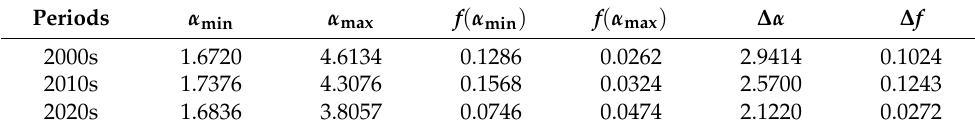
Figure 8. The multifractal spectrum of the Yellow River Basin in the ( a ) 2000s, ( b ) 2010s, and ( c ) 2020s. Table 1. Multifractal characteristic parameters of the river network in the Yellow River